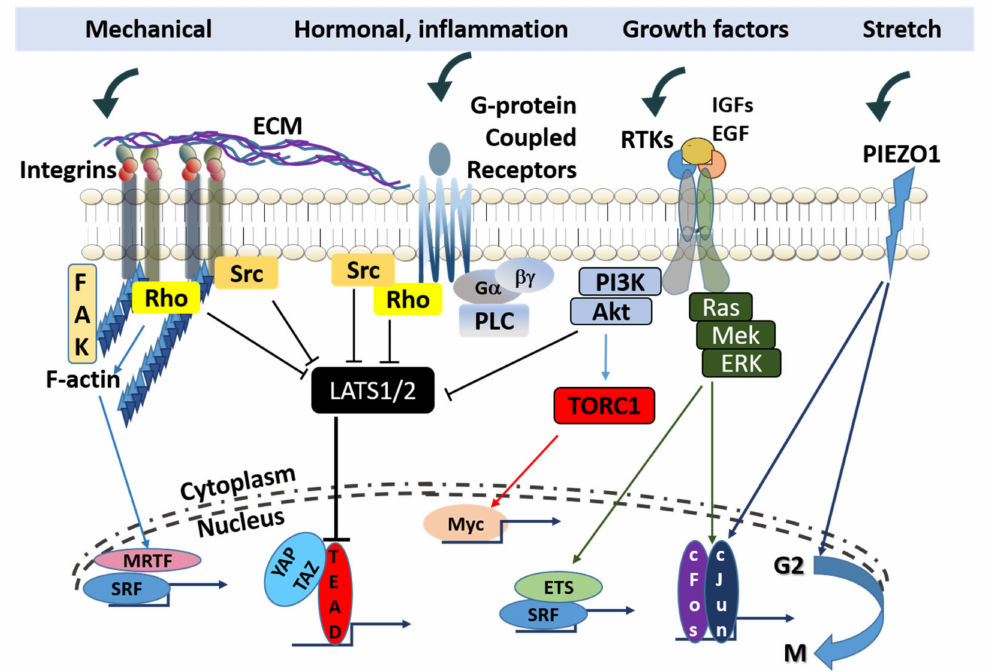
Figure 2. The integration of mechanical, hormonal, and growth signaling determining transcriptional regulation. Signaling routes in cancer cells activated by mechanical forces and stretching converge with growth pathways mediated through receptor tyrosine kinase (RTK) growth factor receptors and G-protein coupled receptors (GPCRs) upon LATS1/2, to modulate the Hippo pathway. Shared targets of the F-actin kinase (FAK) and Piezo1 include the serum response factor (SRF) and AP-1. (blunt ends indicate inhibition and arrows indicate